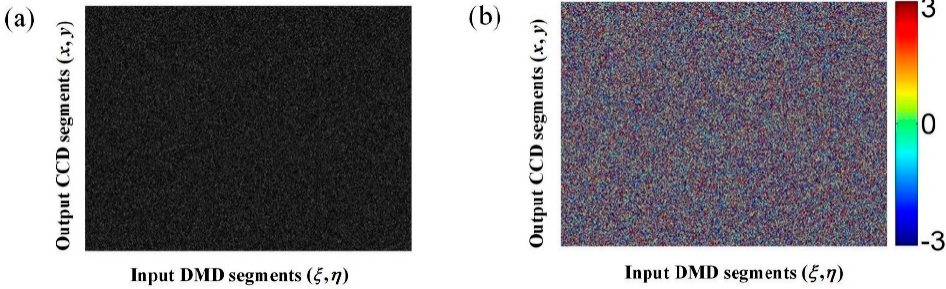
Figure 3. Sketch map of the measured round-trip TM T O → E ( x , y ; ξ , η ) . Amplitude ( a ) and corresponding phase ( b ), respectively. Color bar: phase in radian.